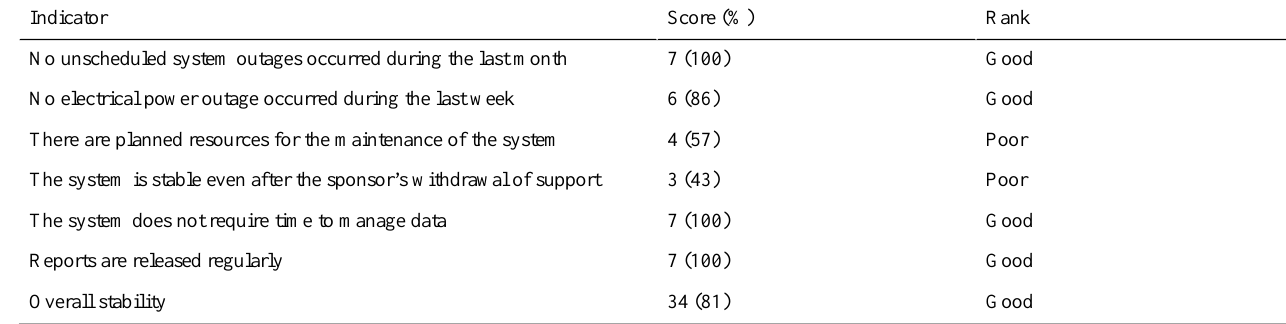
Table 3. The scores (score percent, %) and rank of the stability indicators as assessed by the central-level